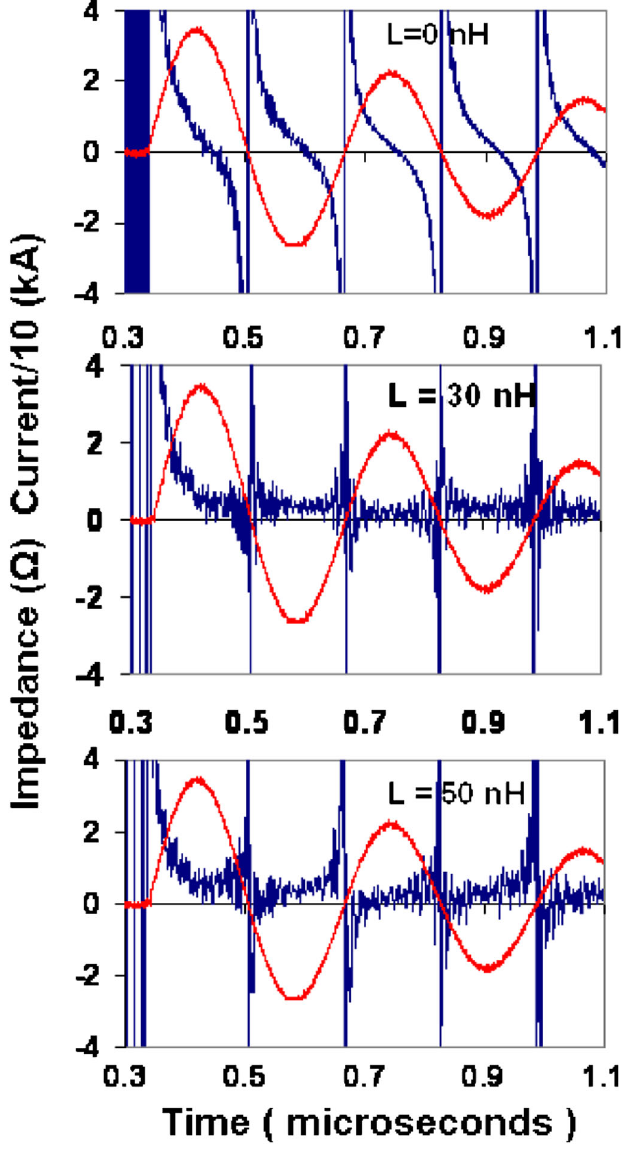
results.FIG. 19. (Color) Voltage on top and bottom of the Sandia switch and switch current for a (cid:2) 60 kV shot into a short circuit. We could directly calculate switch impedances at each of the peaks of the current waveform from the voltage and current measure- ments. These values of impedance are shown in purple and their values are listed on the right-hand